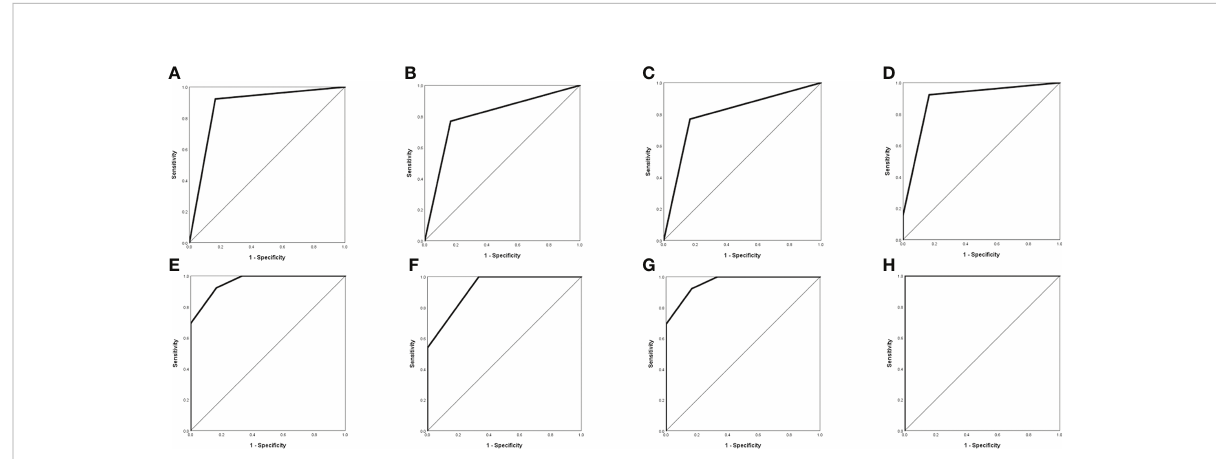
FIGURE 3 Evaluation of differential diagnosis ef fi cacy for MUT BRAF and WT BRAF in E-GBM. (A) : The AUC for quantity of ring was 0.878 (95% CI 0.681- 1.000); (B) : The AUC for quantity of located lobe was 0.801 (95% CI 0.578-1.000); (C) : The AUC for shape of ring was 0.801 (95% CI 0.578- 1.000); (D) : The AUC for quantity of ring + quantity of located lobe was 0.891 (95% CI 0.715-1.000); (E) : The AUC for quantity of ring + shape of ring was 0.962 (95% CI 0.880-1.000); (F) : The AUC for quantity of located lobe + shape of ring was 0.923 (95% CI 0.794-1.000); (G) : The AUC for quantity of ring + quantity of located lobe + shape of ring was 0.962 (95% CI 0.880-1.000); (H) : The AUC for quantity of ring + quantity of located lobe + shape of ring + thickness of ring + maximal diameter of ring + maximal thickness of ring was 1.000 (95% CI